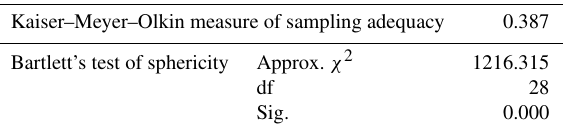
Table 1. KMO and Bartlett’s